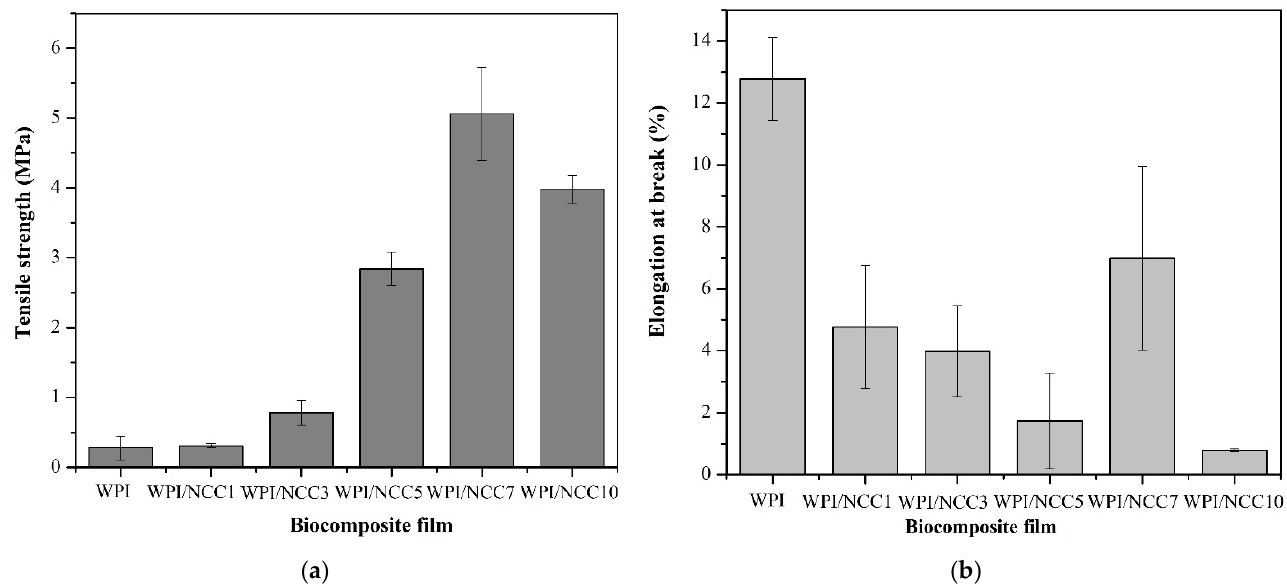
Figure 2. Mechanical properties of the biocomposite WPI film: ( a ) tensile strength and ( b ) elongation at break.